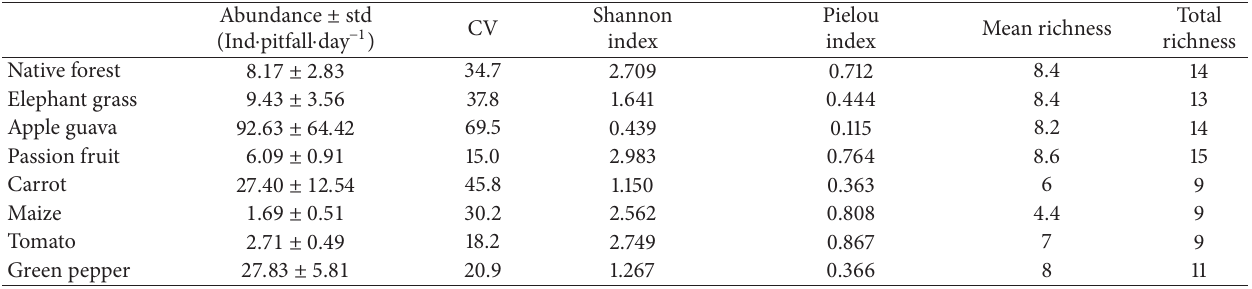
Table 5: Parameters and indices used to assess arthropod communities under native forest and the different agricultural land uses